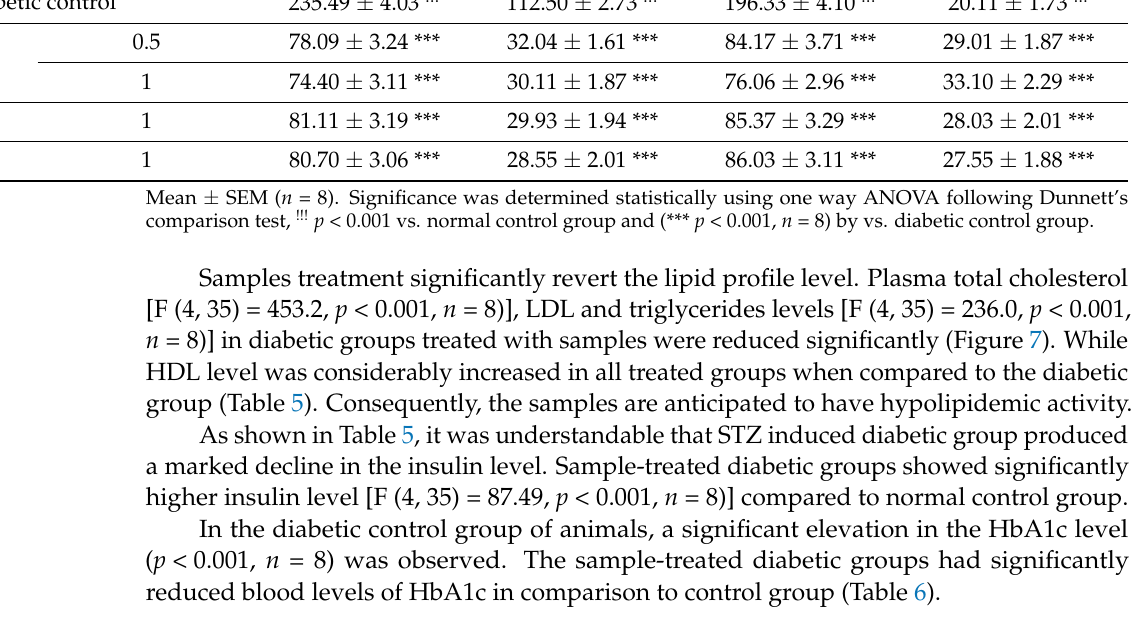
Table 6. Effect of Rp-Nc on serum insulin and HbA1c